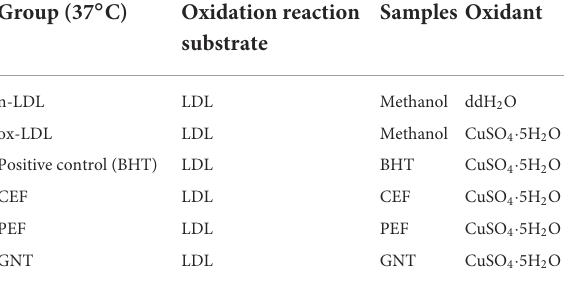
TABLE 2 Oxidation incubation system of low-density